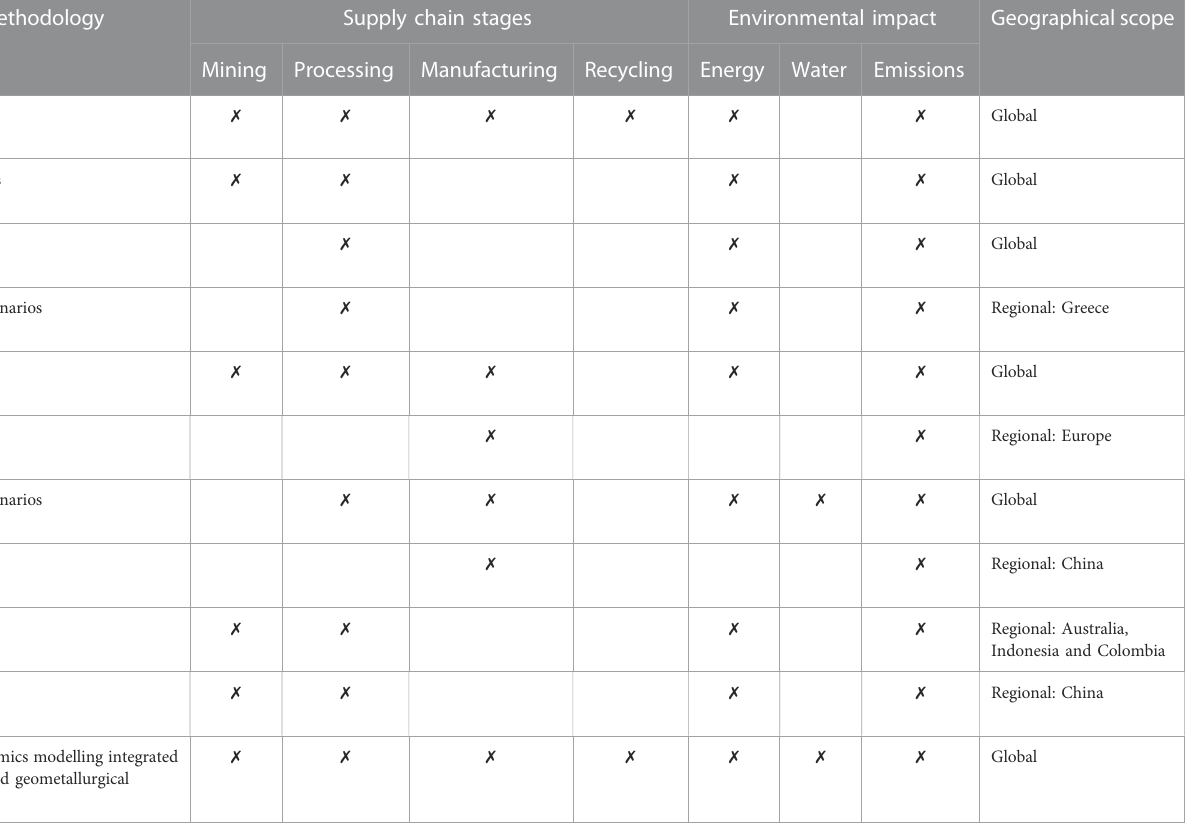
TABLE 1 Summary of investigation on the environmental impact of nickel